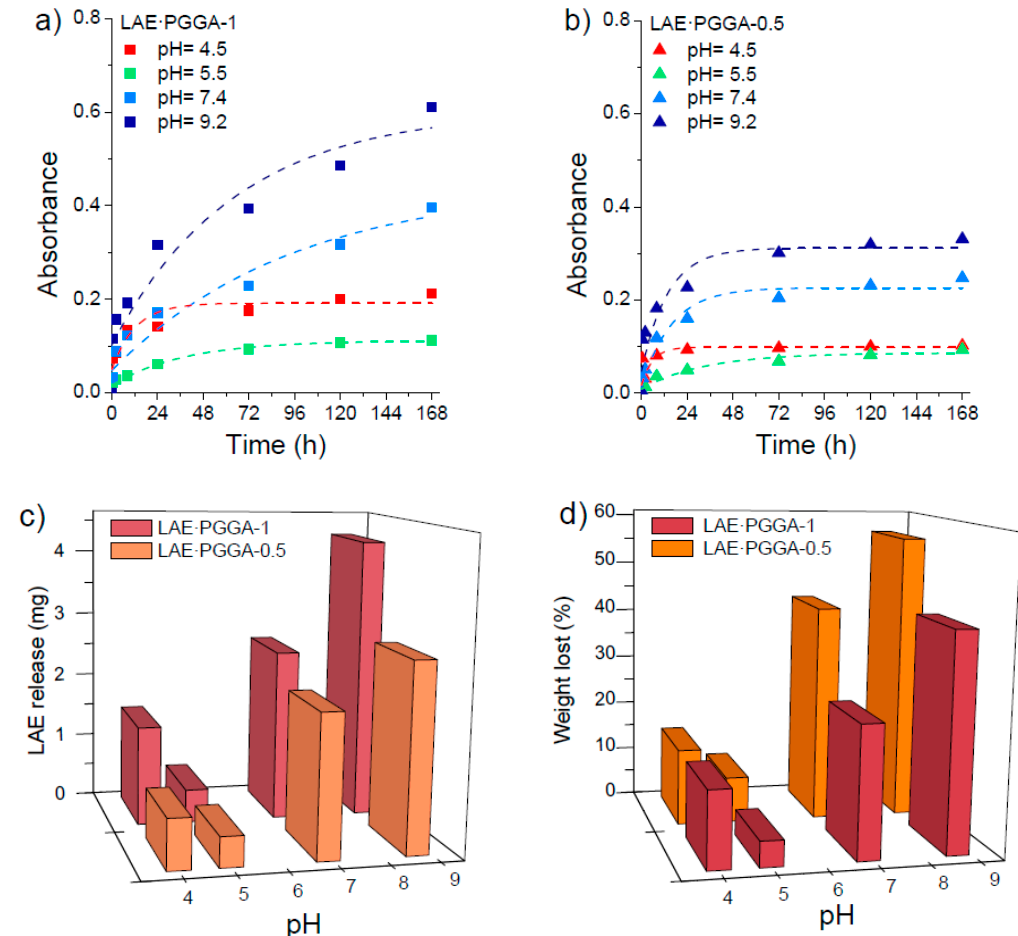
Figure 7. Dissociation of LAE·PGGA-1 ( a ) and LAE·PGGA-0.5 ( b ) complexes in aqueous buffer at the indicated pH. In ( c , d ) the amount of released LAE and the film weight loss are respectively compared for the two complexes after seven days of incubation at the assayed pH.